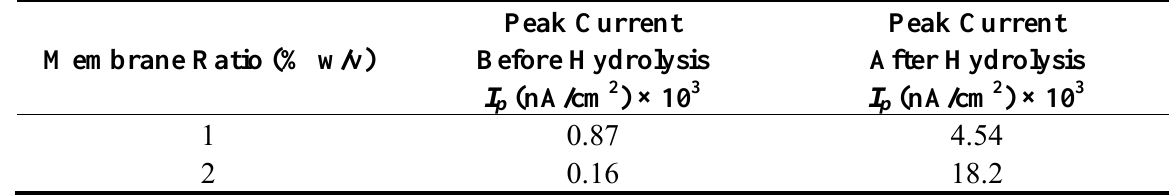
Table 1. Hydrolysis effect on electrode